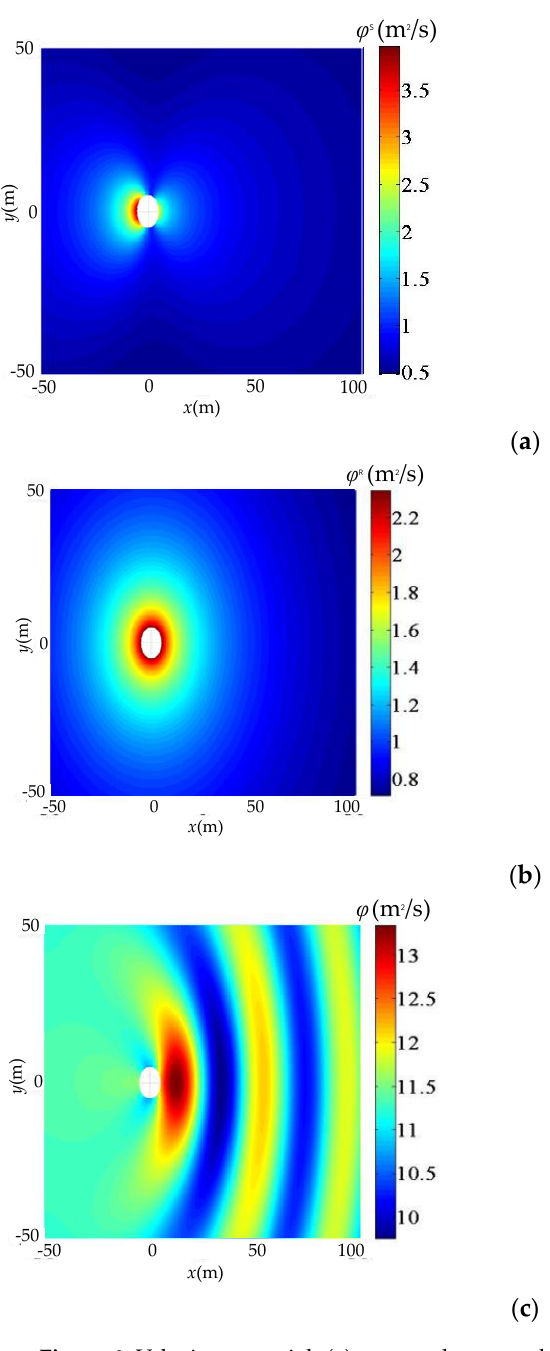
Figure 6. Velocity potential: ( a ) scattered wave velocity potential of Float 1 ( left ) and Float 2 ( right ); ( b ) radiation wave velocity potential of Float 1 ( left ) and Float 2 ( right ); ( c ) the velocity potential of Float 1 ( left ) and Float 2 ( right ).